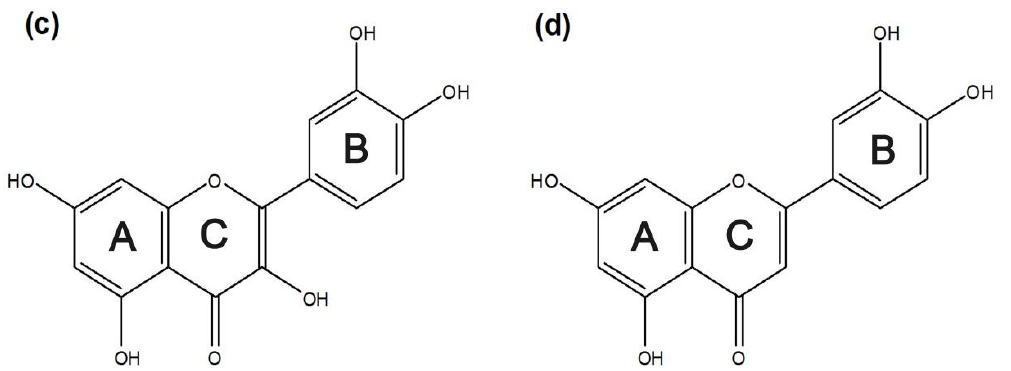
Figure 1. Chemical structures of the flavonoids: ( a ) hesperetin; ( b ) naringenin; ( c ) quercetin; and ( d ) luteolin.